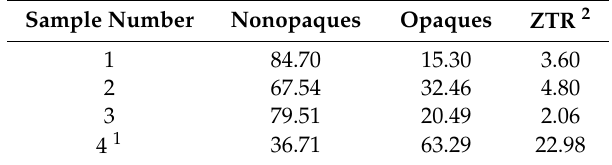
Table 9. Some aspects of the mineral composition of El-Hebal dunes and beach